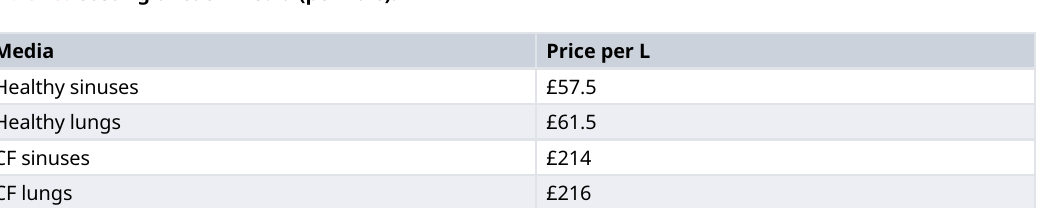
Table 15. Costing of each media (per